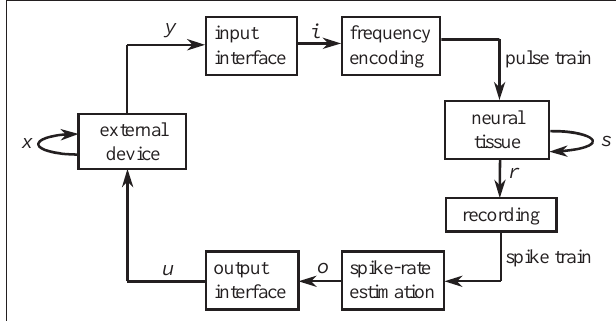
FIGURE 1 | Experimental paradigm. The box representing the neural tissue has two incoming arrows: one is a recurrent arrow and represents the state s , the other represents the input signal i , which is conveyed using frequency encoding. The signal recorded by the extracellular electrode contains information about the state s in the form of population spike train. The spike train is converted into a sequence of estimated spike rates, which serve as an output signal o from the tissue. The box representing the external device has two incoming arrows, like the neural tissue box. The change in state of the external device, x , depends only upon the current state and the control signal u (Eq.